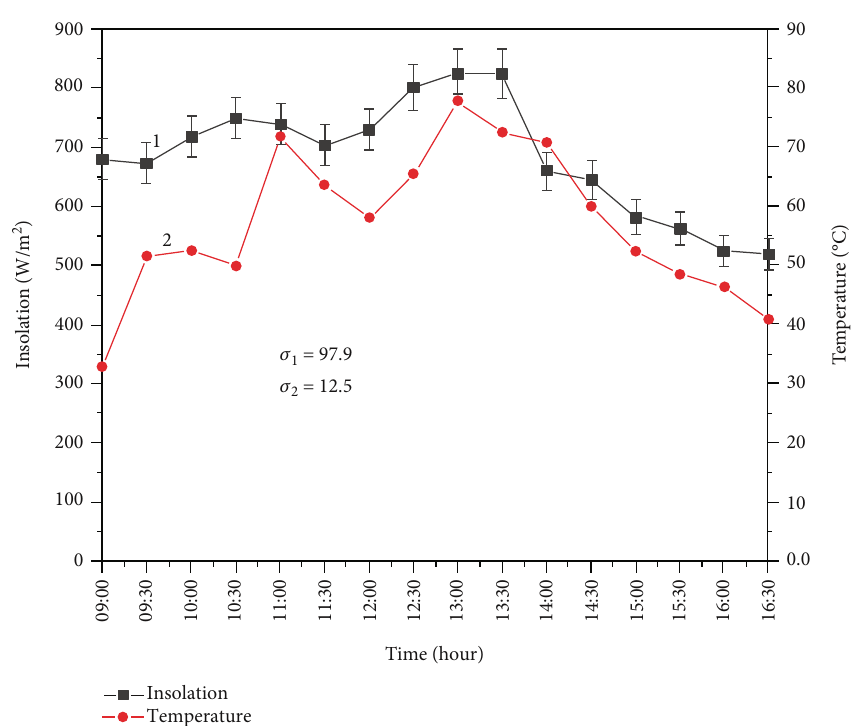
Figure 7: Variations of insolation and temperature at the outlet of the collector.